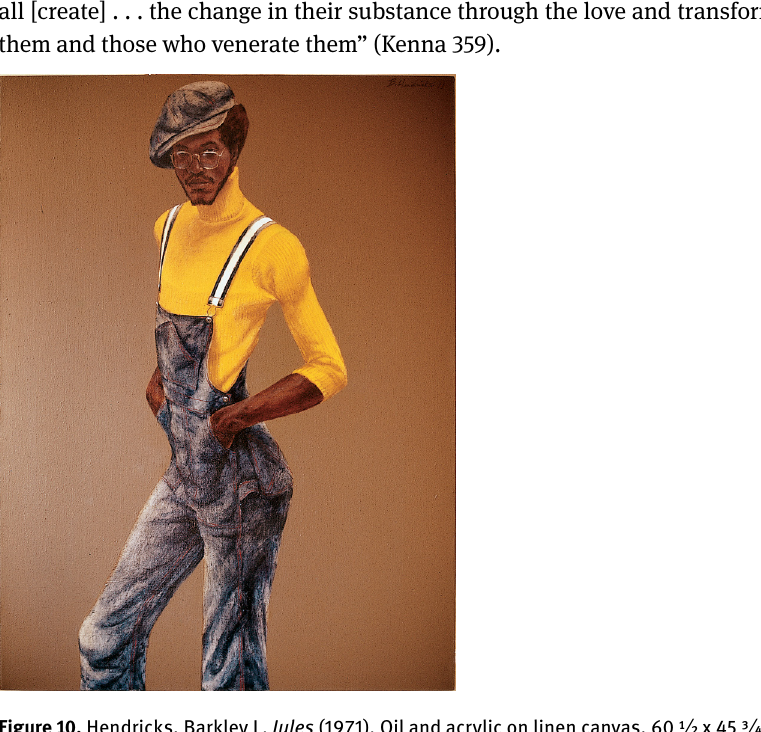
Figure 10. Hendricks, Barkley L. Jules (1971). Oil and acrylic on linen canvas, 60 ½ x 45 ¾ in. ©Estate of Barkley L. Hendricks. Courtesy of Jack Shainman Gallery, New York.